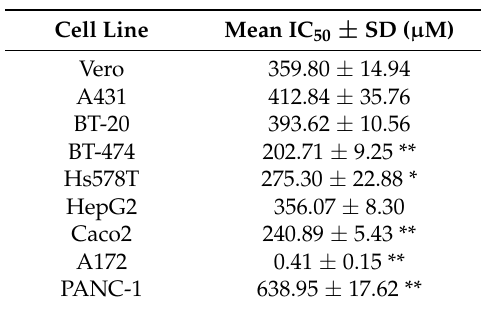
Table 1. Toxicity of ETM to normal and tumor cell lines.